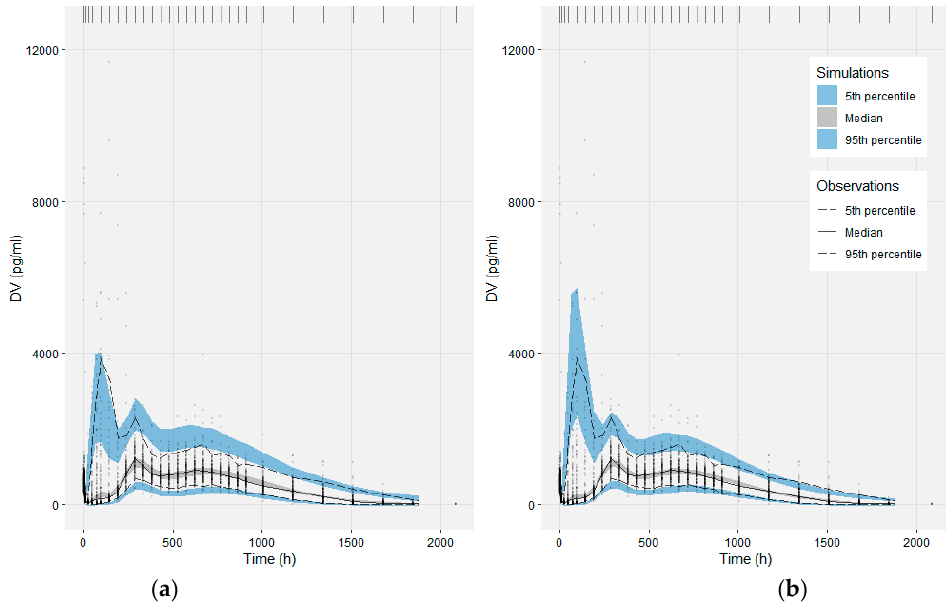
Figure 4. Visual Predictive Checks of the base model ( a ) and the final model ( b ). The median, 5th and 95th percentiles of Figure 5. Visual Predictive Checks of the final model, stratified on cluster, ( a ) for cluster 1 and ( b ) for the observations (lines) are compared with the corresponding 95% confidence intervals of the 1000 simulated datasets cluster (shaded areas).